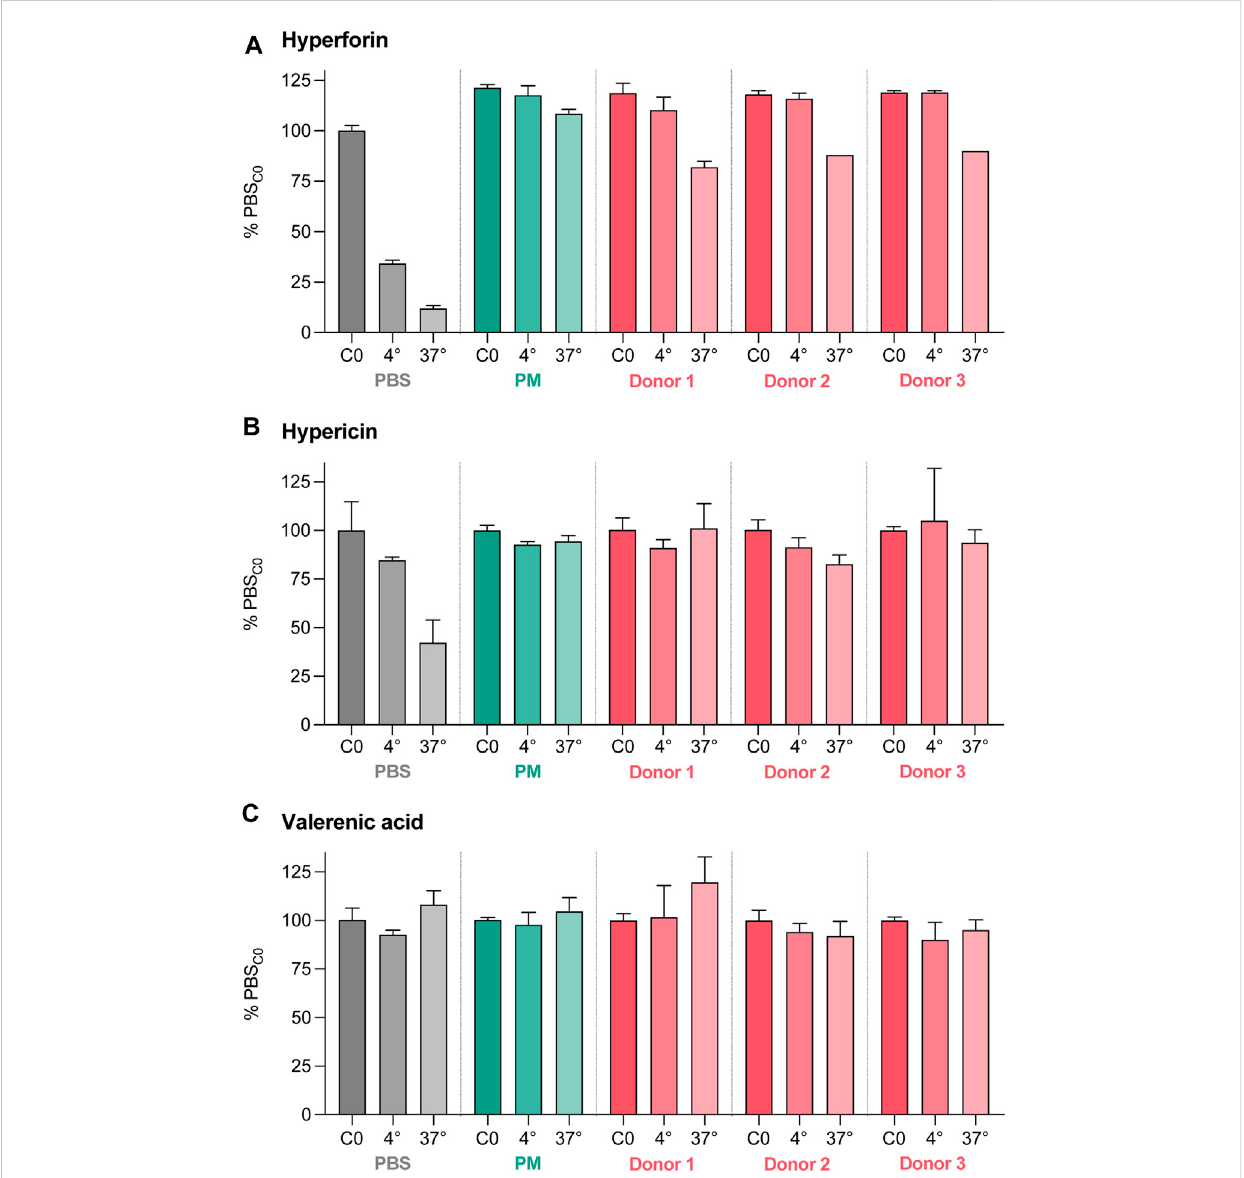
FIGURE 6 Stability data for hyperforin (A) , hypericin (B) , and valerenic acid (C) expressed as percentage (%) of the initial concentration (C0) in PBS. The stability test was performed for 360 min at two different temperatures (4 ° C and 37 ° C) and three different matrices (PBS), perfusion medium (PM), and placental homogenates from three different donors. Differences due to matrix effects were excluded in a separate experiment (Supplementary Figure S2). All data are represented as mean ±